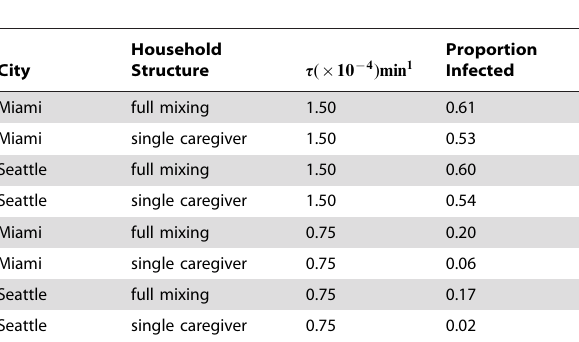
Table 2. Simulated infection attack rate by city, household structure, and transmissibility.